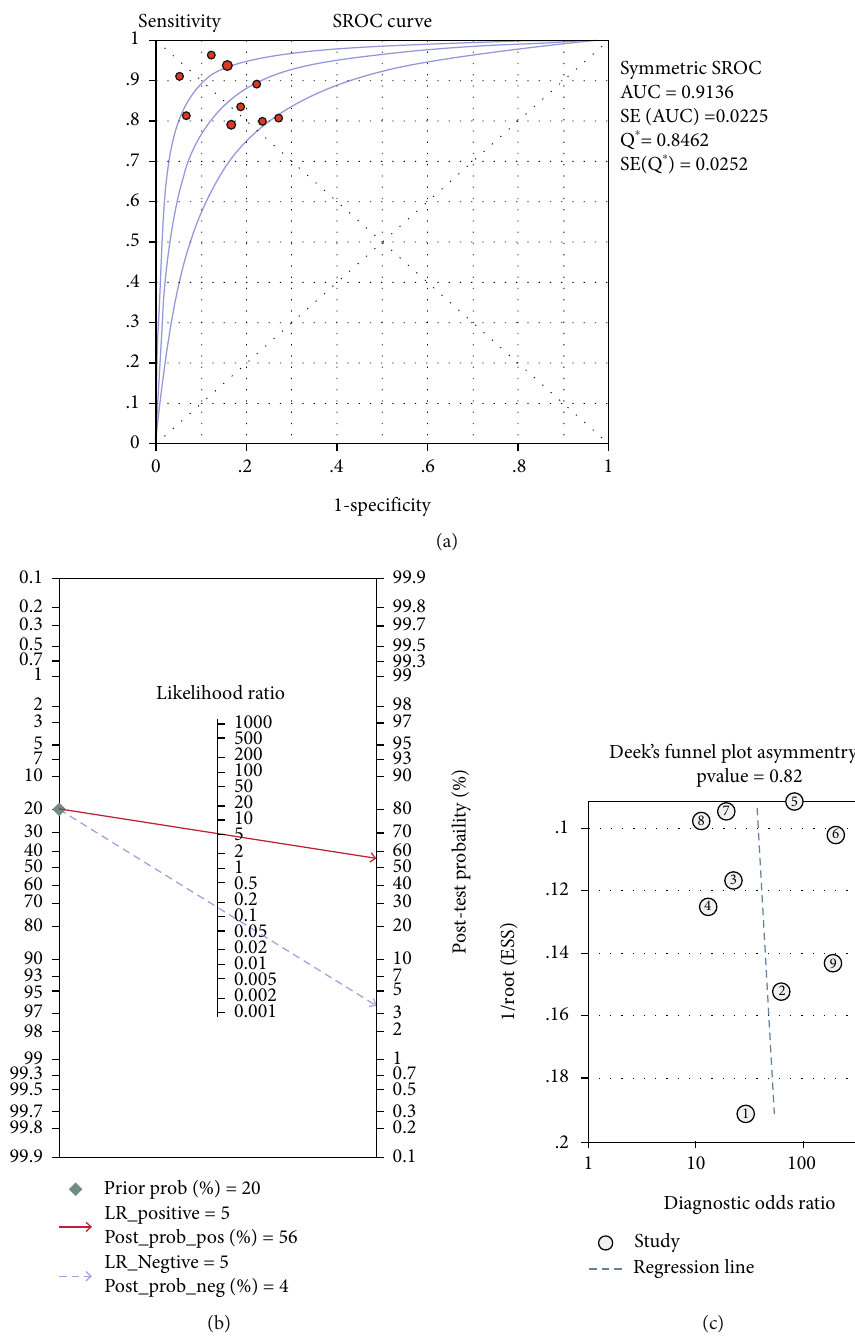
Figure 4: The SROC curve, publication bias, and Fagan Nomogram for MD in detecting benign and malignant breast lesions. SROC: summary receiver operating characteristic; MD: mean di ff